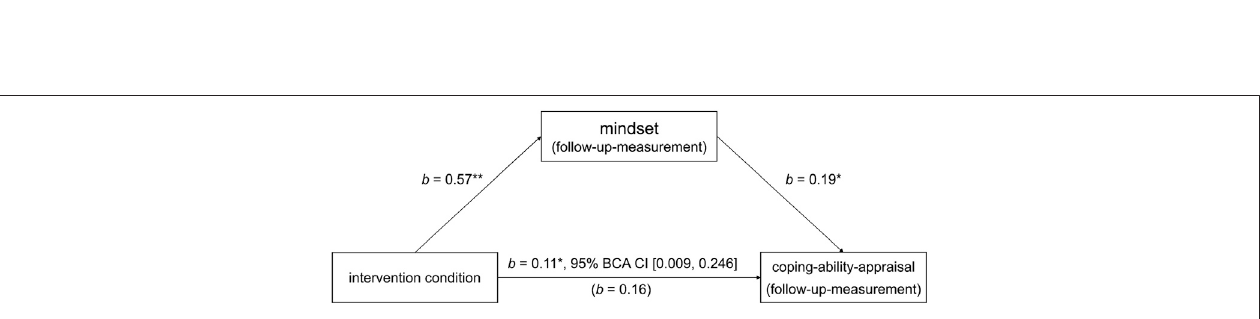
FIGURE3| Mediationmodelfortherelationshipbetweentheinterventionandcoping-abilityappraisalatfollow-upmeasurementmediatedbymindsetatfollow-up measurementindicatedbystandardregressioncoef fi cients.Thestandardizedregressioncoef fi cientbetweentheinterventionandcoping-abilityappraisal,controllingfor mindset, is in parentheses (direct effect). BCA CI, bootstrapped CI. * p < 0.05, ** p < 0.01, and *** p < 0.001. N (cid:1)